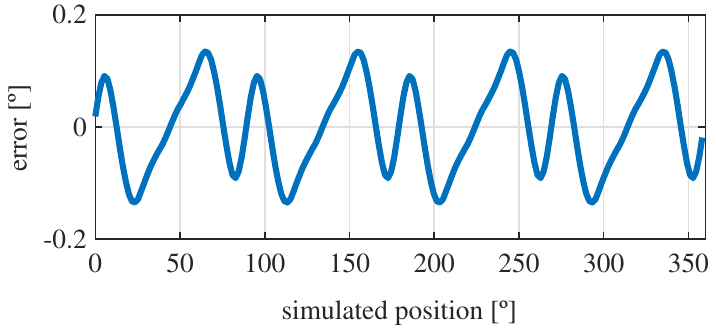
Figure 33. Toroidal slotless skewed resolver position